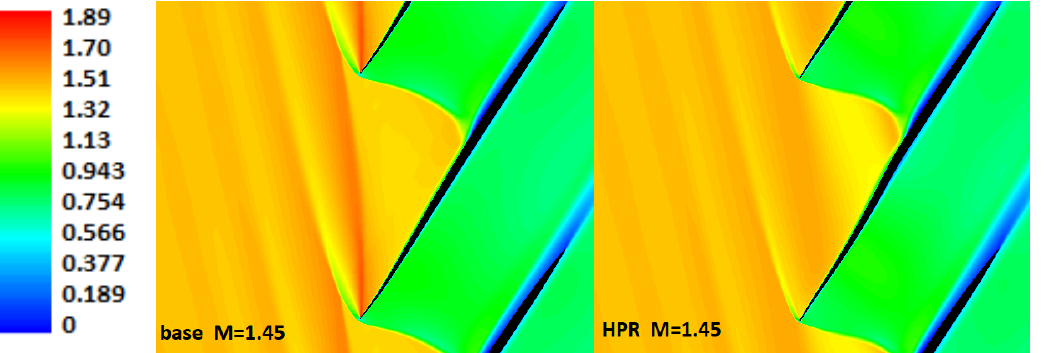
Figure 19. Mach contours of profiles with HPR at Mach 1.45.